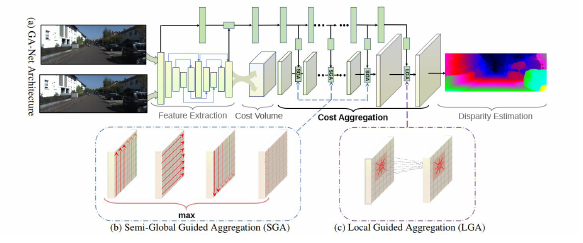
Figure 1. Overview of GA-Net (Zhang et al.,